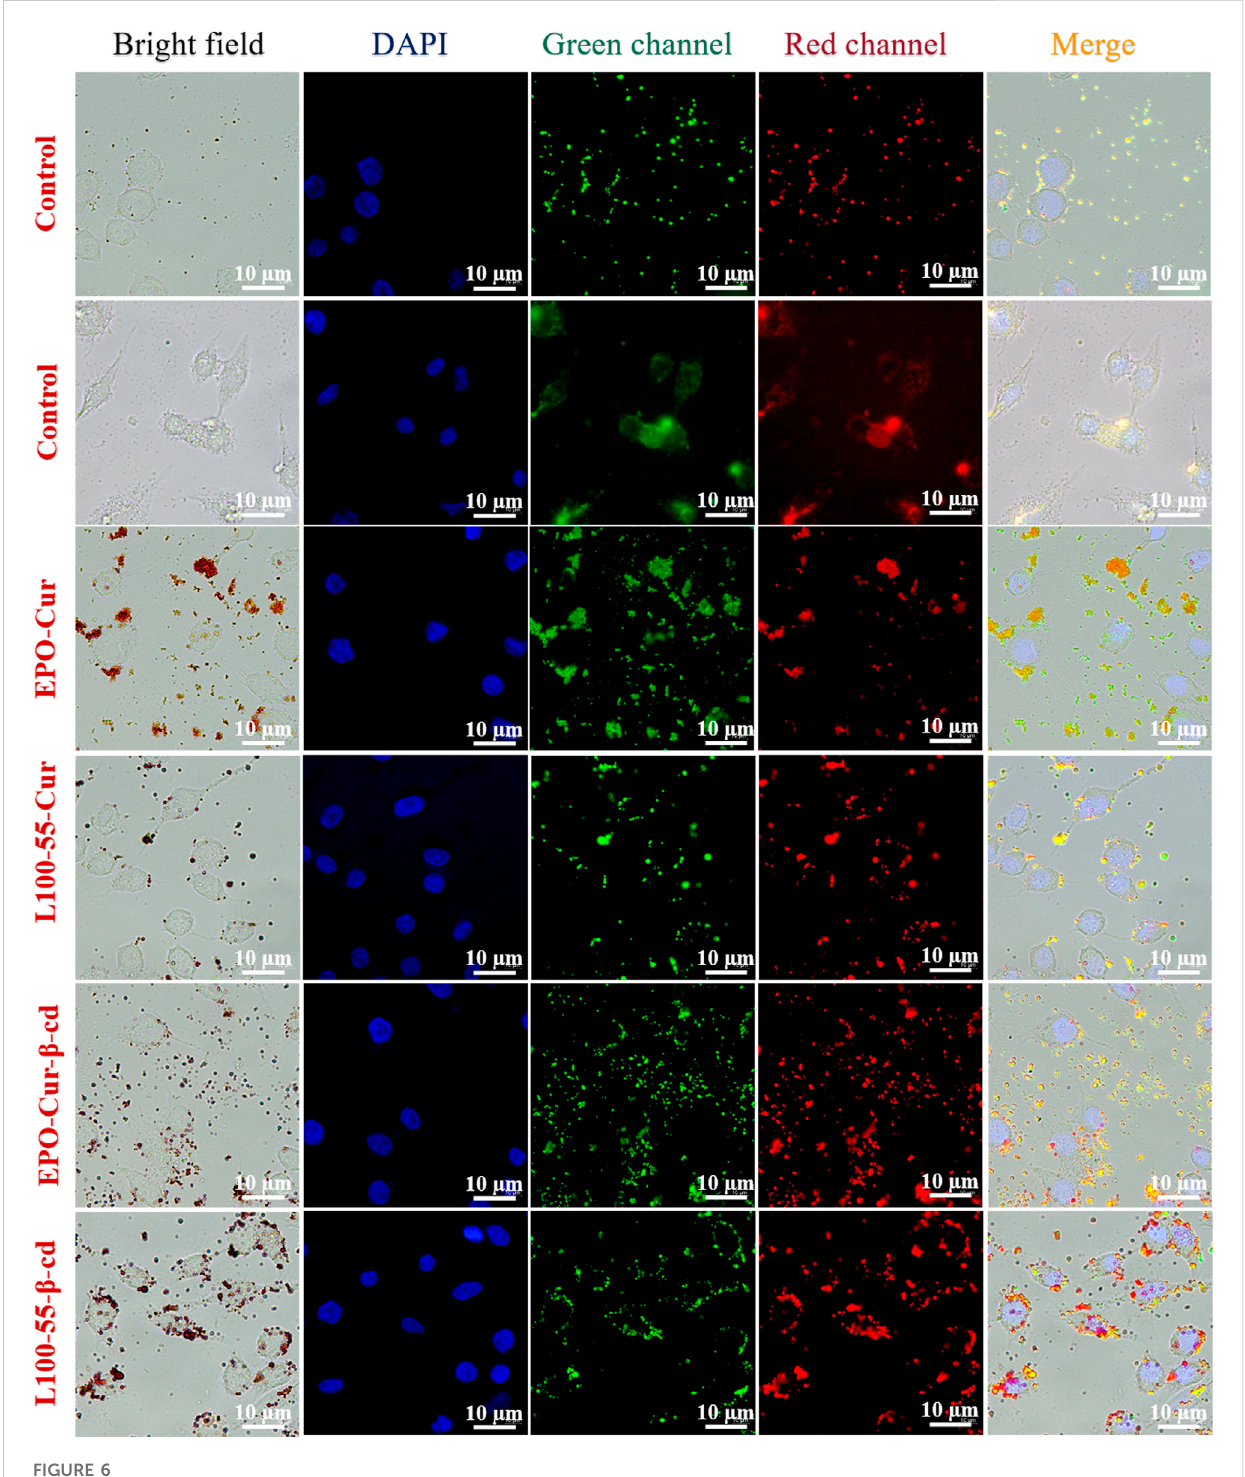
FIGURE 6 Cellular imaging of L100-55-Cur, L100-55-Cur- β -cd, EPO-Cur and EPO-Cur- β -cd.